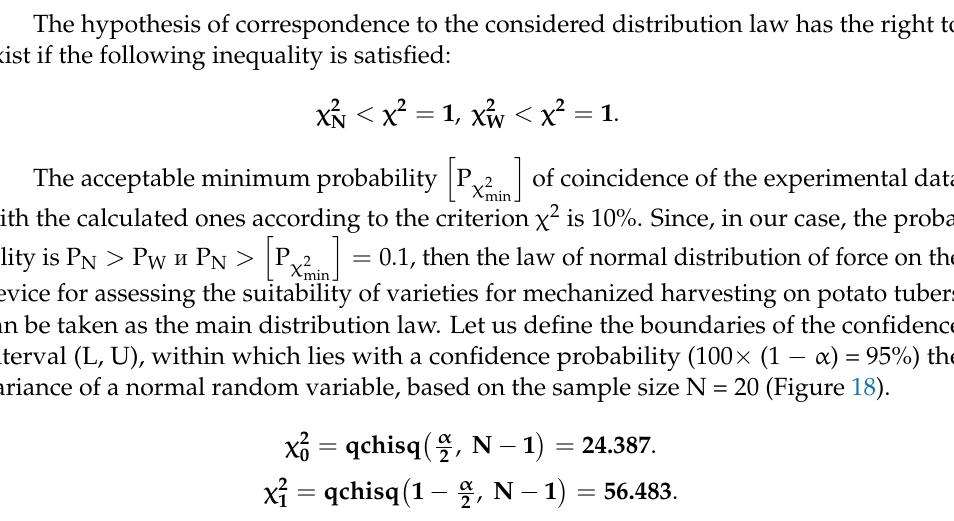
Figure 17. Differential functions of theoretical distribution laws: normal and